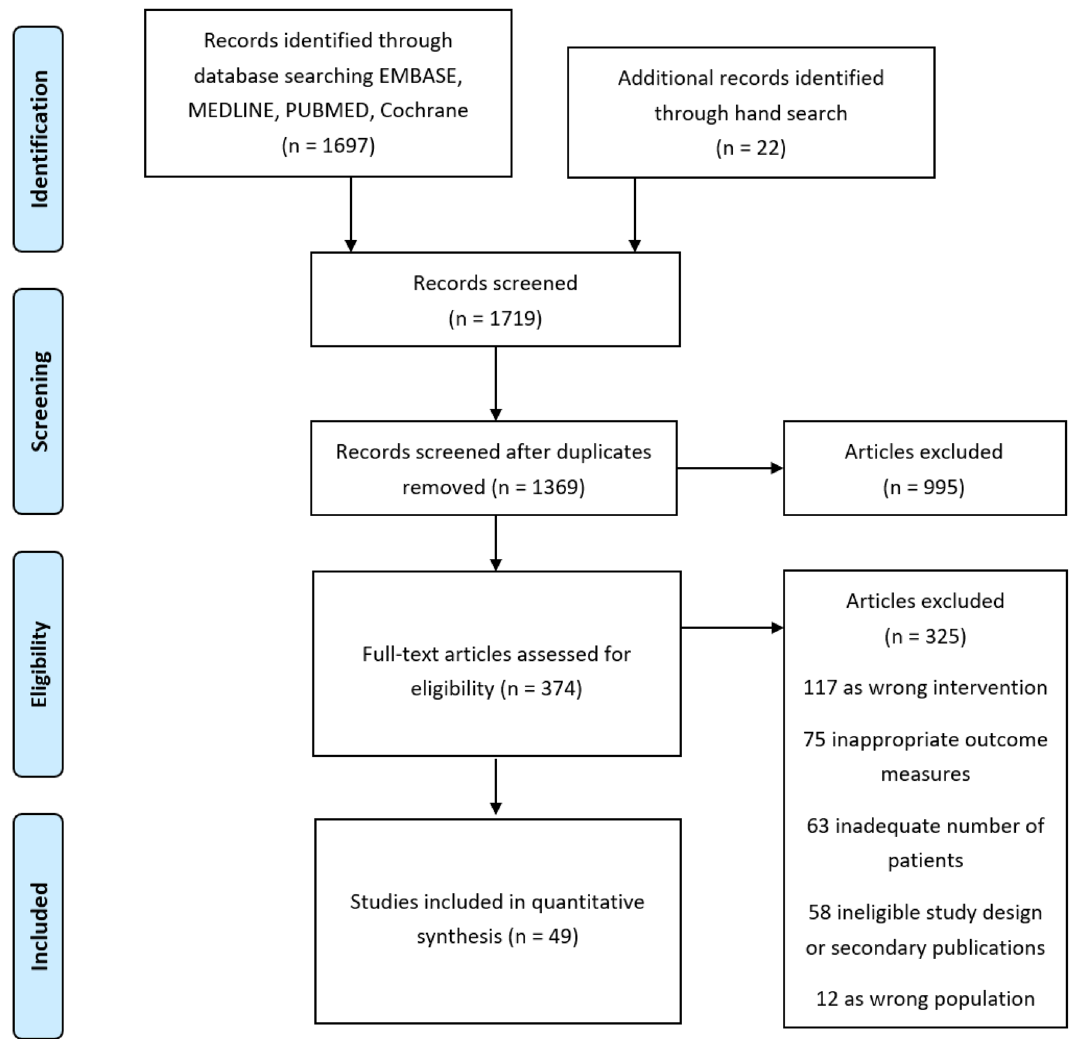
Figure 1. PRISMA Flow diagram 12 with details of the number of studies identified, screened, assessed and included in the final